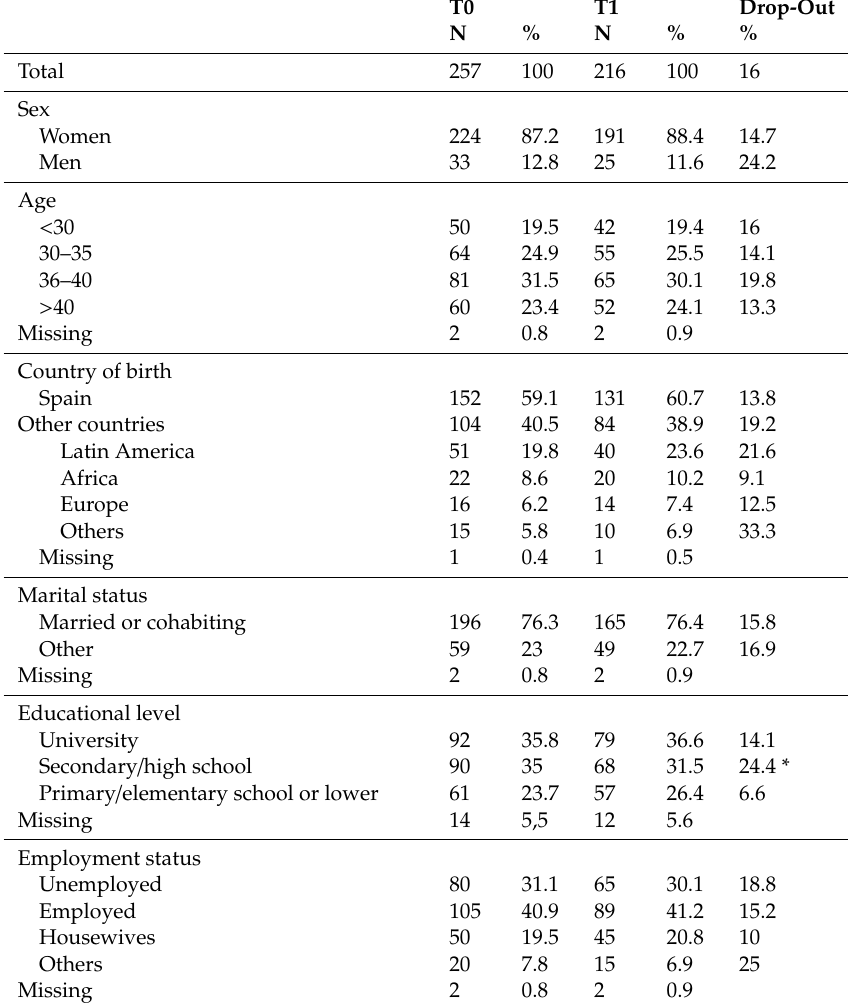
Table 1. Sociodemographic characteristics of the study population before and after intervention. T0